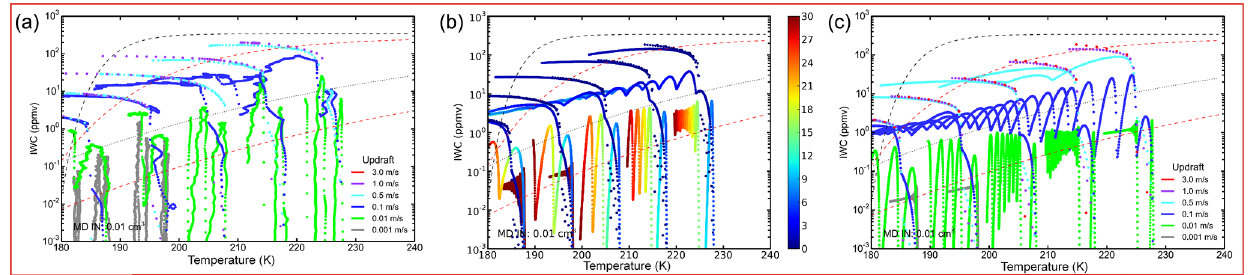
Figure 8. Cirrus scenario HET + HOM | 0 . 01 − MD . Same as in Fig. 7 (red box) (and also Figs. 5 and 6), but (a) with superimposed temperature sedi − 0 . 9 fluctuations, (b) color coded by time, (c) with strong sedimentation (sedi − 0 .